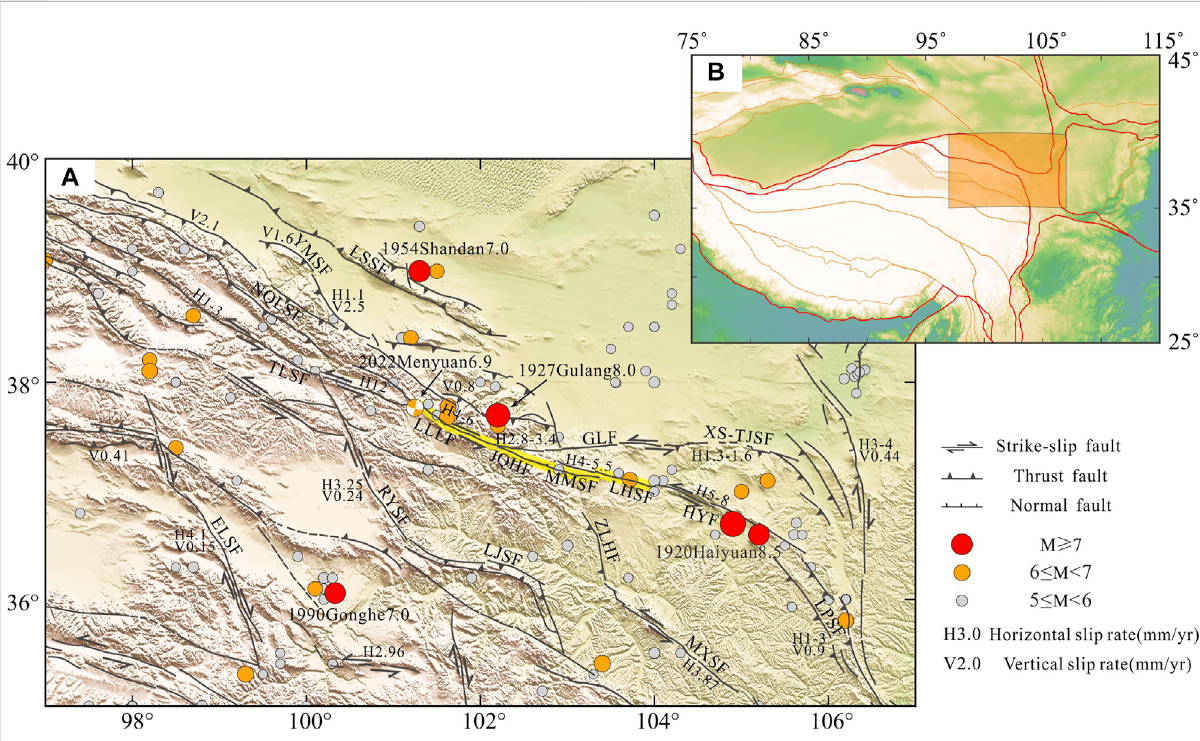
FIGURE 1 (A) Active faults and earthquakes in the northeastern margin of the Tibetan Plateau. Black lines represent fault lines mapped by (Xu et al., 2017). Gray, orange, and red circles indicate the locations of M 5 ~ 6, M 6 ~ 7, and ≥ M 7 earthquakes that have occurred since 1900, respectively. The focal mechanism solutions were obtained from Global CMT Catalog (http://www.globalcmt.org/CMTsearch.html). Yellow line follows the Tianzhu seismic gap (Gaudemer et al., 1995). The Geologic slip rate from Yuan et al. (2004). LSSF: Longshoushan fault; YMSF: Yumushan fault; NQLSF: Northern Qilian Shan fault; TLSF: Tuolaishan fault; LLLF: Lenglongling fault; JQHF: Jinqianghe fault; MMSF: Maomaoshan fault; LHSF: Laohushan fault; HYF: Haiyuan fault; GLF: Gulang fault; XS – TJSF: Xiangshan – Tianjingshan fault; LPSF: Liupanshan fault; ELSF: Elashan fault; RYSF: Riyueshan fault; LJSF: Lajishan fault; ZLHF: Zhuanglanghe fault; MXSF: Maxianshan fault (B) Location of the study area in relation to the Tibetan Plateau. The orange box is the area shown in (A) . The orange lines are active block boundaries mapped by Zhang et al.